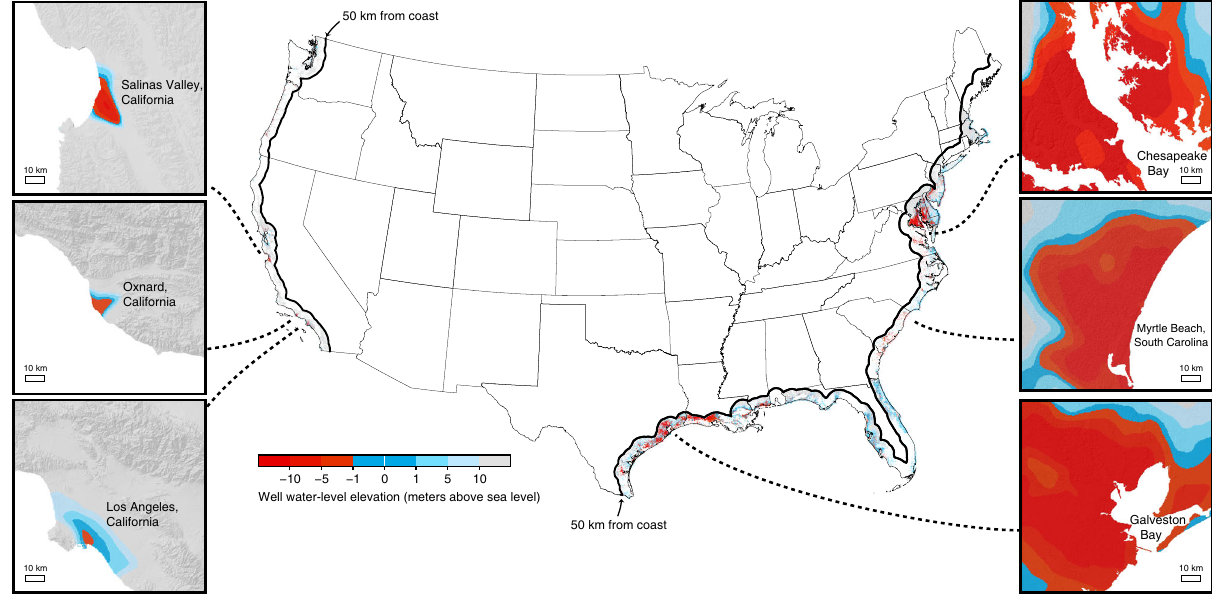
Fig. 2 Well water elevations across the contiguous United States. Each point on the center map represents a unique well, and its color corresponds to the well water elevation measured more recently than January 1, 2000. Red points correspond to well water elevations that are more than one meter below sea level. For monitoring wells reporting more than one well water elevation measurement, we show the median of all measurements made after the year 2000. We only present data for wells located within 50 km of the coast. Well water elevations below mean sea level (i.e., red points) are concentrated in densely populated parts of California ’ s coast (Los Angeles), much of the west-central part of the Gulf (south) coast, and portions of the Atlantic Coast (e.g., western Delmarva Peninsula). Six 100 km by 100 km maps are shown for speci fi c areas of each coastline (red-blue shades are interpolations of well water elevations; interpolated surfaces follow the same color scale as point data in continent-wide